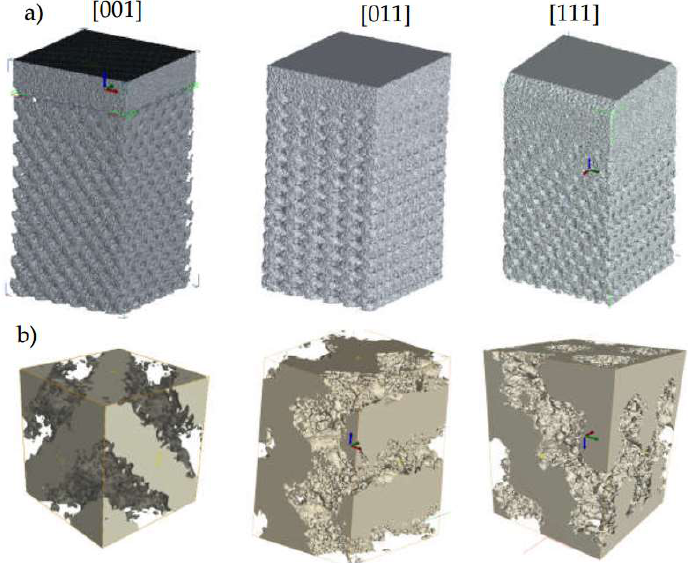
Figure 6. 3-D reconstructed images of the differently oriented lattice specimens: ( a ) illustrations of the entire digitalized area; ( b ) selected regions corresponding to the periodic unit cell arrangements.